Question: Express in one sentence what the figure is showing.
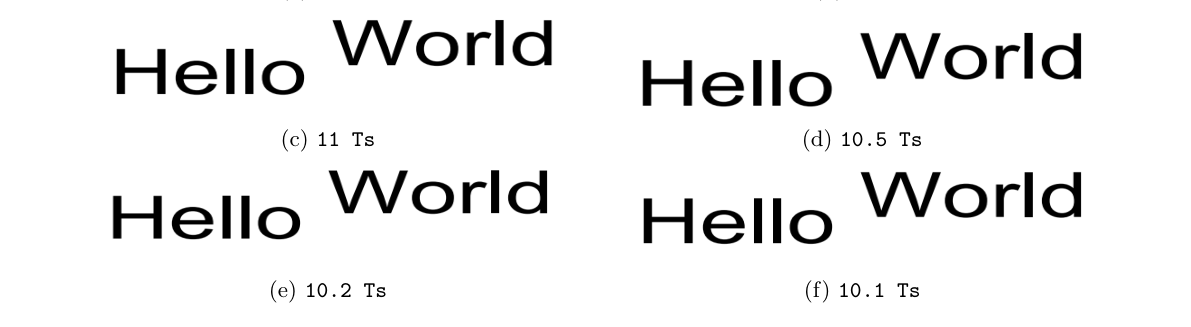
Answer: Ts Operator - control, 20%, 10%, 5%, 2%, 1% (5-10%)